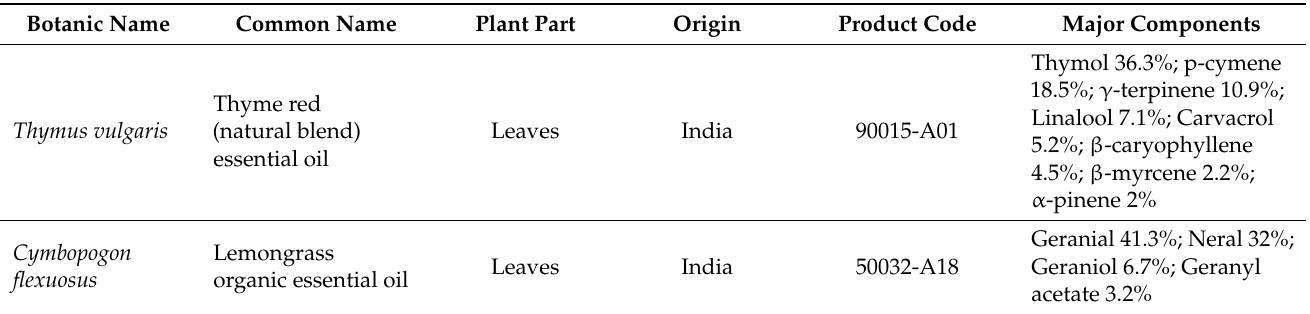
Table 2. EOs used in the present